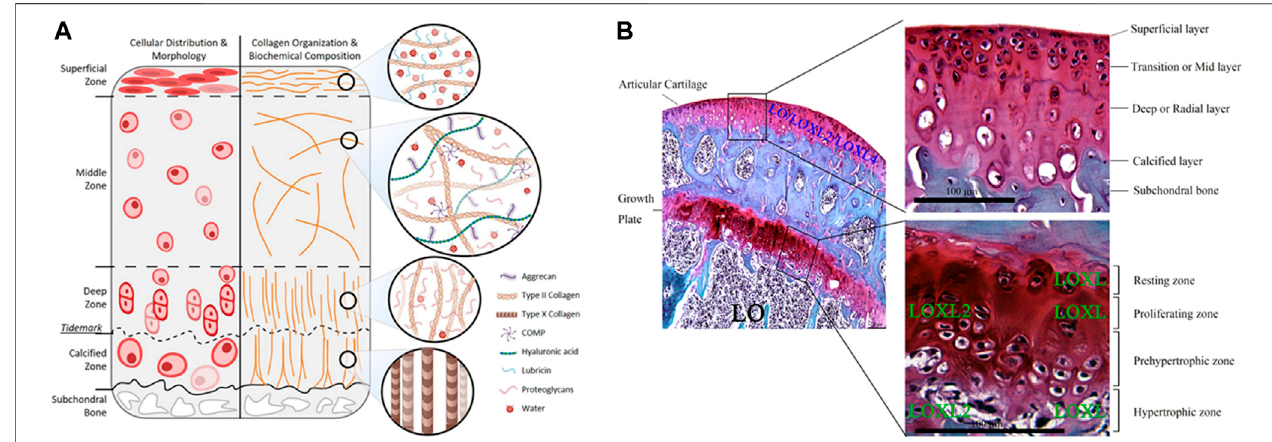
FIGURE 2 | Schematic representation and histological images of osteochondral structures. (A) Schematic representation of articular cartilage and the gradient distribution structure. Reproduced with permission (Thorp et al., 2021). Copyright: © 2021 by the authors. (B) Safranin O-Fast Green staining shows the different expression of LO, LOXL and LOXL2 (scale bar = 100 µm). Lysyl oxidase: LO; lysyl oxidase like-2: LOXL2; Lysyl oxidase-like enzymes: LOXL. Reproduced with permission (Lin et al., 2020). Copyright: © 2020 Lin, Xu, and